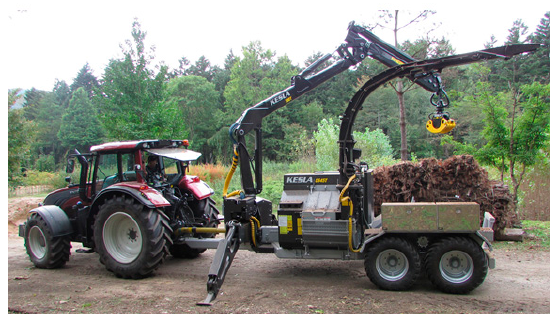
Figure 2. Tractor mounted drum chipper (KESLA C645T).